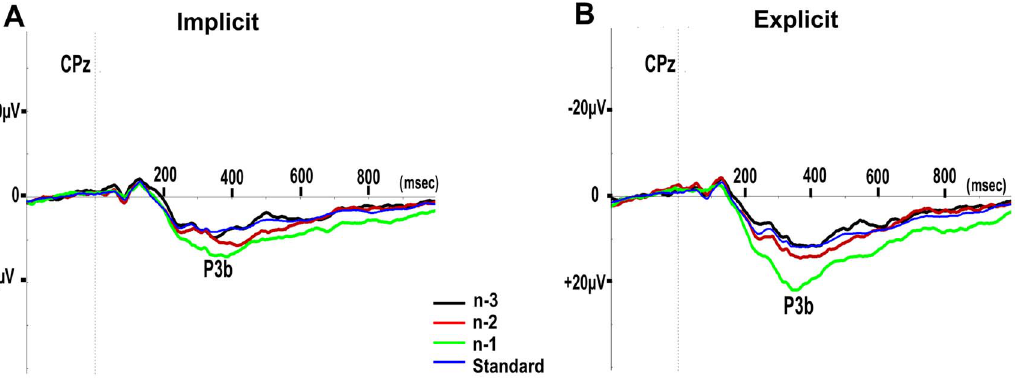
Figure 4. Grand average at CPz for the three stimuli comprising the predictive sequence. The first least-informative (n-3), the middle (n-2) and last most informative (n-1); and for random preceding standards (Standard) for implicit (A) and explicit (B) sessions. Vertical dotted lines indicate time of stimulus presentation onset.